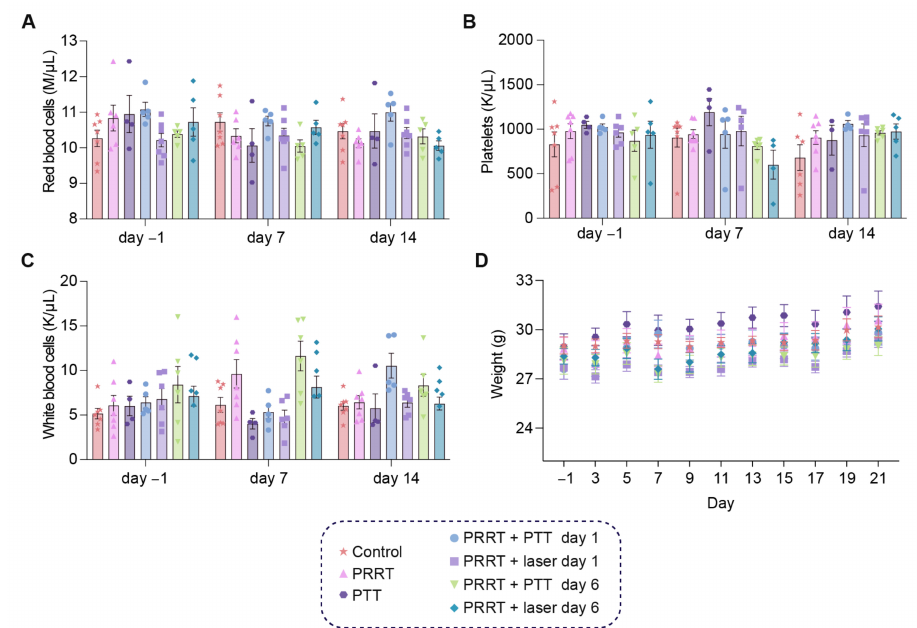
Figure 4. Blood cell analysis after combined [ 177 Lu]Lu-DOTA-TATE and PTT. ( A ) Red blood cells (M/ µ L) at day − 1, day 7, and day 14 for all groups (Control, PRRT, PTT, PRRT + PTT day 1, PRRT +